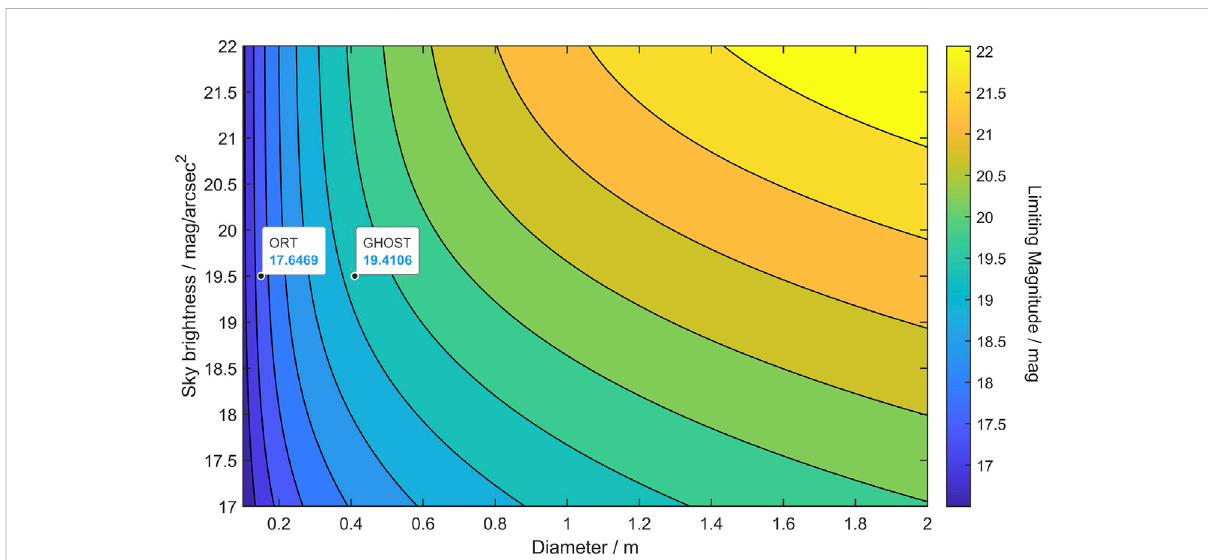
FIGURE 6 Estimation of the Limiting Magnitude for different telescope diameters and Sky Magnitudes calculated by Eq. 12 for an exposure time of 60 s with parameters based on the GHOST telescope (G01). Calculation results for the ORT and GHOST telescopes are marked in the graph.